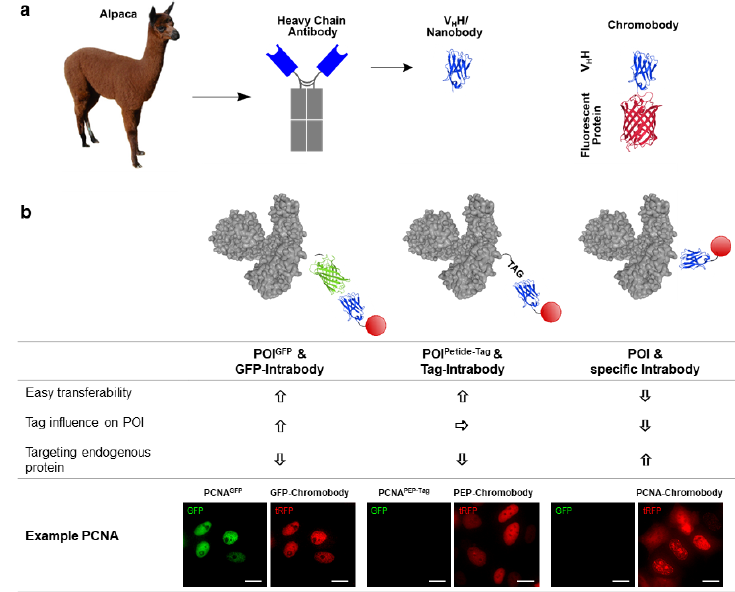
Figure 1. Intrabodies for visualization. ( a ) Schematic depiction of nano- and chromobodies derived from heavy-chain antibodies of Camelidae ( b ) Illustration of di ff erent labelling strategies for visualization of the protein of interest (POI) using intrabodies coupled to a detectable moiety and summary of their characteristics: POI genetically coupled to GFP recognized by a GFP intrabody, POI genetically coupled to a short peptide-tag recognized by the tag-specific intrabody and POI directly recognized by a specific intrabody. Model protein structures adapted from PDBs 3OGO, 5H88, 1EMA and 5LEW. Representative images of living Hela cells transiently expressing PNCA GFP and the GFP-specific chromobody (tagRFP), PNCA PEP-tag and the PEP-tag-specific chromobody (tagRFP) or PCNA-specific chromobody (tagRFP) as examples for the described labeling strategies are shown. Scale bar: 25 µ